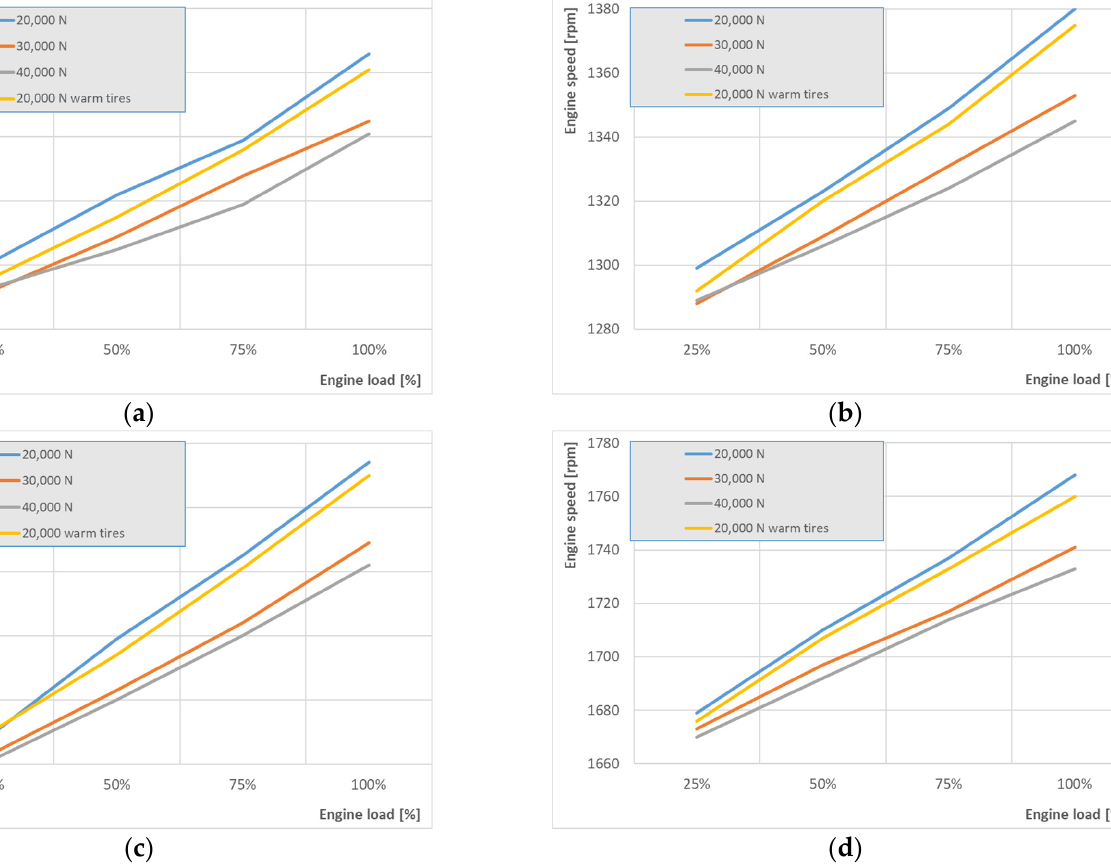
Figure 9. Graphs of differences in engine speed for rollers where n is constant, resulting from wheel slip on rollers for different engine speeds in the context of engine load and drive axle load: ( a ) 1000 rpm, ( b ) 1300 rpm, ( c ) 1500 rpm, ( d ) 1700 rpm (authors’ source) .